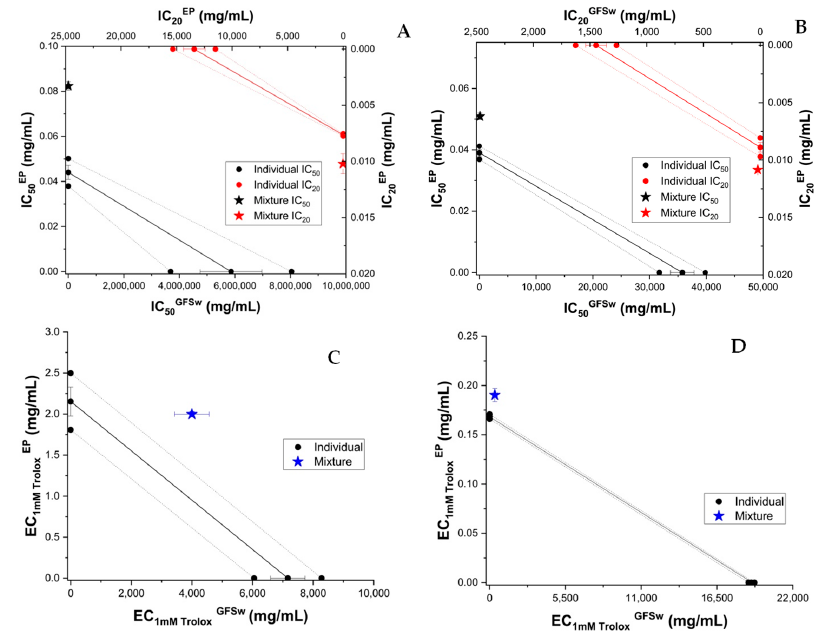
Figure 11. Isobolograms of NaDES (GFSw) and epicatechin (EP) based on IC 50 (half-maximal inhibitory concentration) and IC 20 (inhibitory concentration at 20% substrate inhibition) for DPPH ( A ), and ABTS ( B ) methods, and based on EC 1mM Trolox (effective concentration at 1 mM Trolox equivalent of the samples) for CUPRAC ( C ) and FRAP ( D ) methods. The error bars from three measurements are shown for each value. Confidence intervals at 95% confidence are shown by dashed